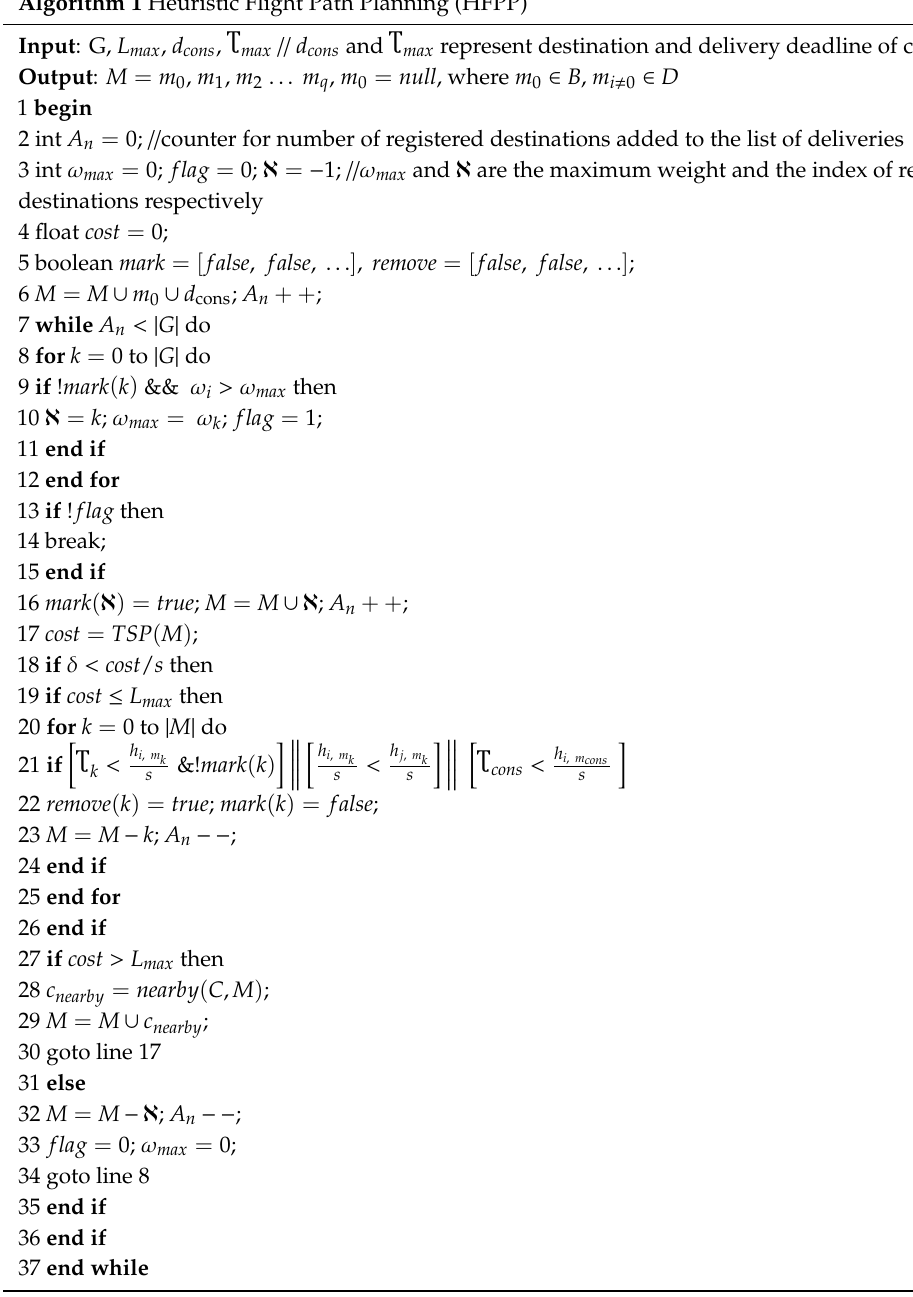
Algorithm 1 Heuristic Flight Path Planning (HFPP)